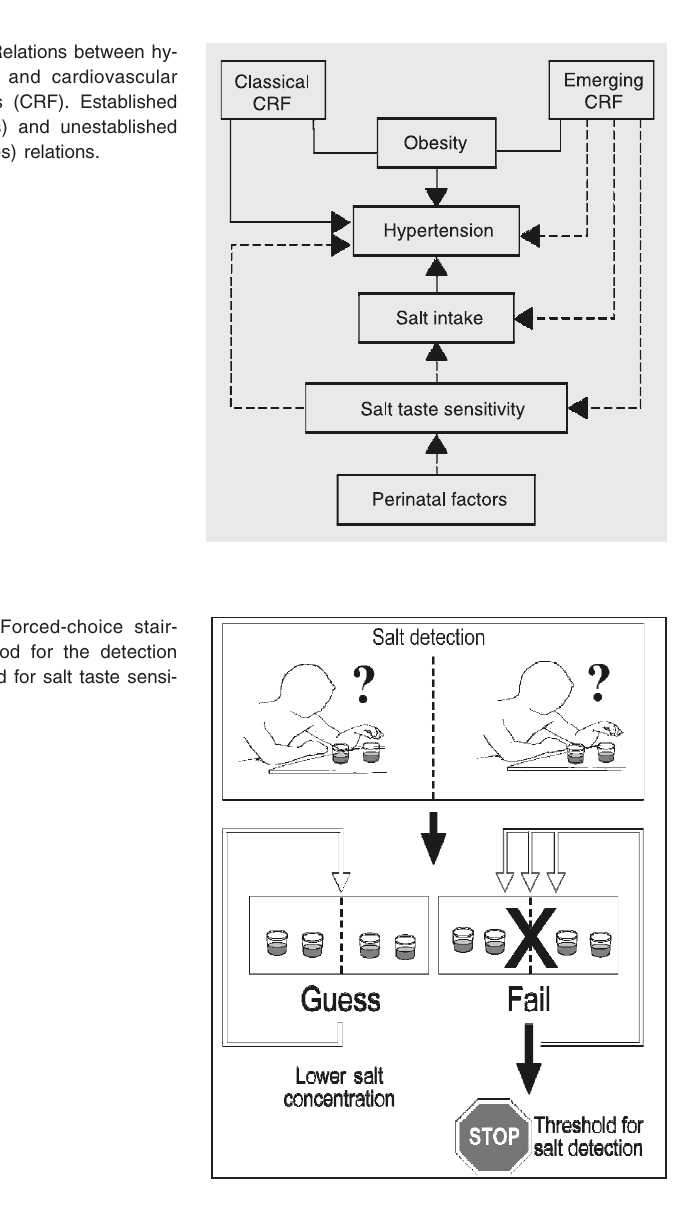
Figure 1. Relations between hy- pertension and cardiovascular risk factors (CRF). Established (solid lines) and unestablished (dotted lines) relations.